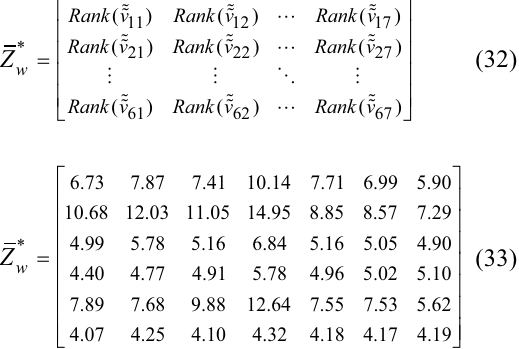
Afterwards, positive and negative ideal solutions are calculated. By employing PIS and NIS values, distances between PIS/NIS and each alternative are found and illustrated in Table 6. In Table 6, the relative degree of closeness values are also represented.